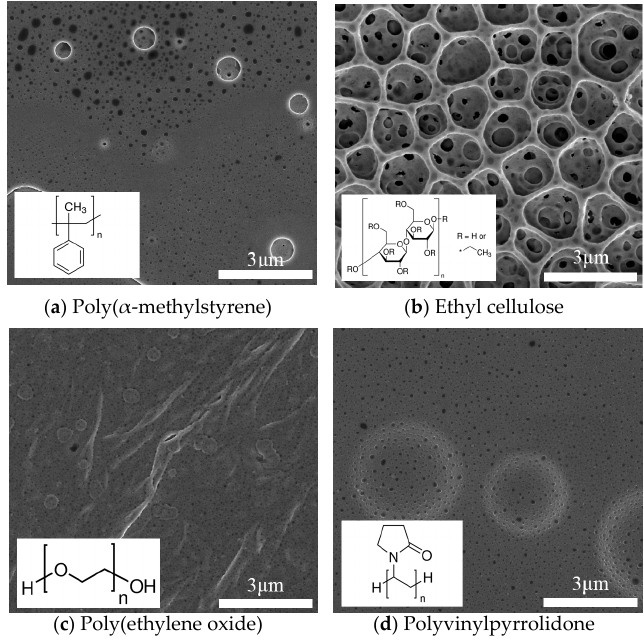
Figure 1. Schematic of chemical structural formulae of four polymers used herein: ( a ) PMS; ( b ) PEO; ( c ) EC; and ( d ) PVP.